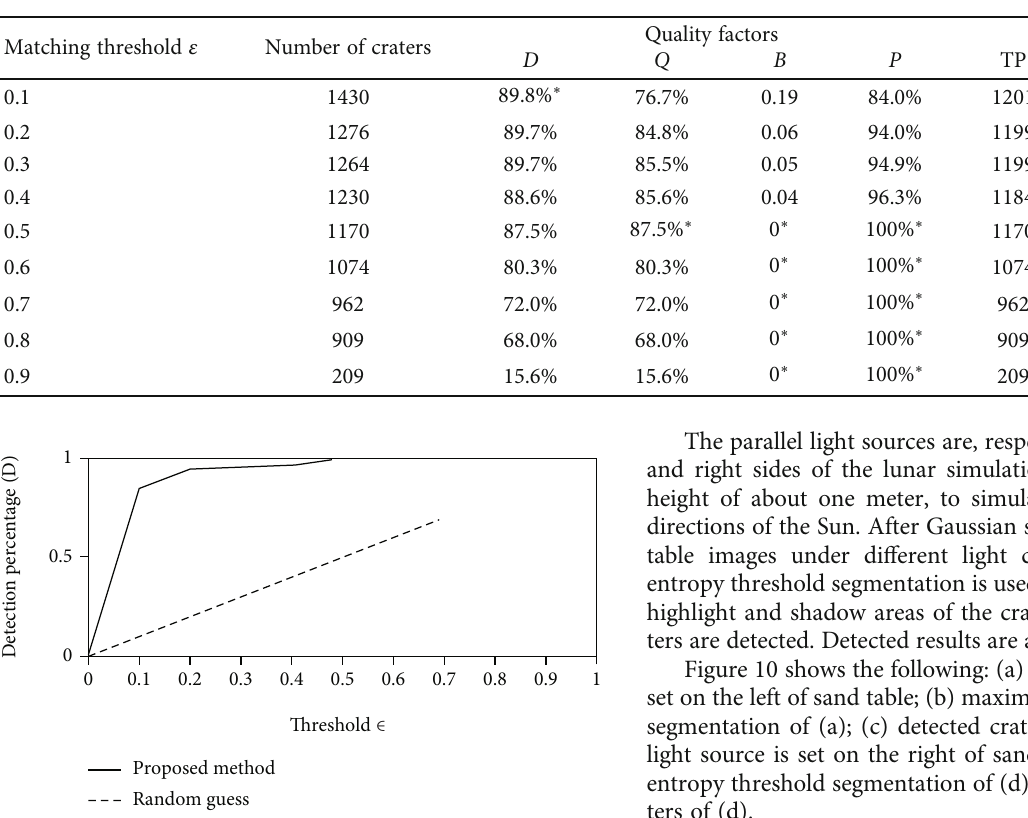
Table 6: Detected crater numbers and quality factors.